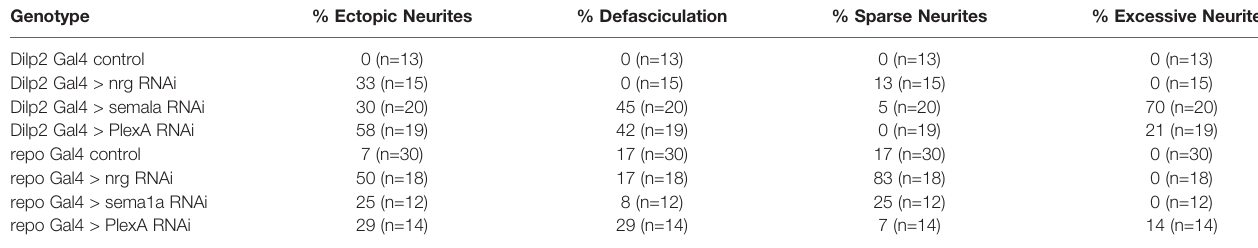
TABLE 2 | IPC and glial requirement of Nrg, Sema-1a, and PlexA.